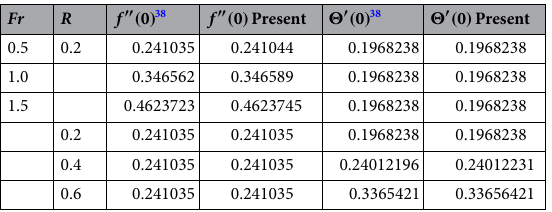
Table 5. Comparison of the present work with 38 . Considering common parameters α = 0.1, φ 1 = φ 2 = 0, Pr =